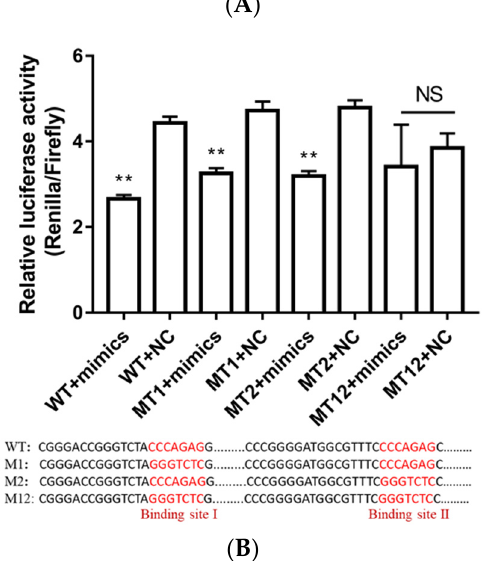
Figure 7. Inhibitory effects of miRNA-326 on NKX3.2 fragments using the dual-luciferase reporter system. ( A ) The schematic diagram of ssc-miRNA-326 was predicted to bind at the two sites (binding site I and binding site II) in NKX3.2 3 (cid:48) UTR. ( B ) The assay was conducted with a fragment spanning the coordinates of binding site I to those of binding site II, in which mutations had been introduced as follows: binding site I and II wild type (WT); binding site I mutation (M1); binding site II mutation (M2); and binding sites I and II mutation (M12). All relative luciferase activity values were normalized to the NC mimics. ** p < 0.01; NS, not significant. The underlined and red sequences both indicate the binding sites of miRNA-326 and NKX3.2